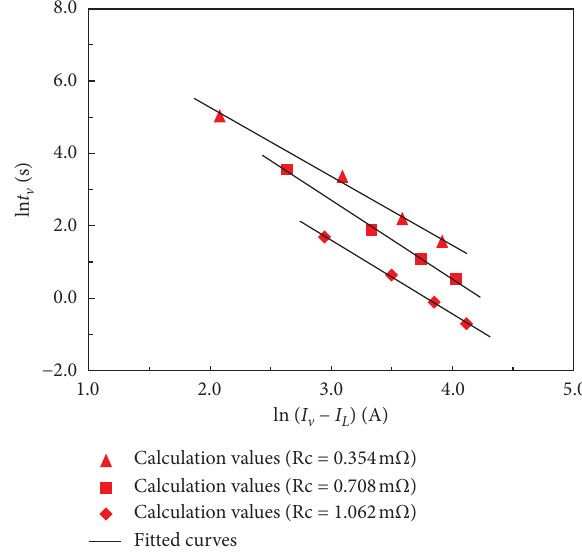
Figure 16: The relationships between ln t three work conditions. Table 6: The values of p , q , and I